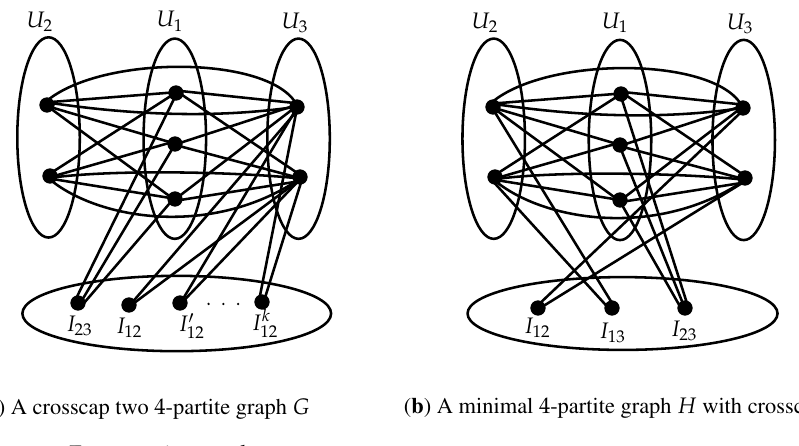
Figure 8. 4-partite